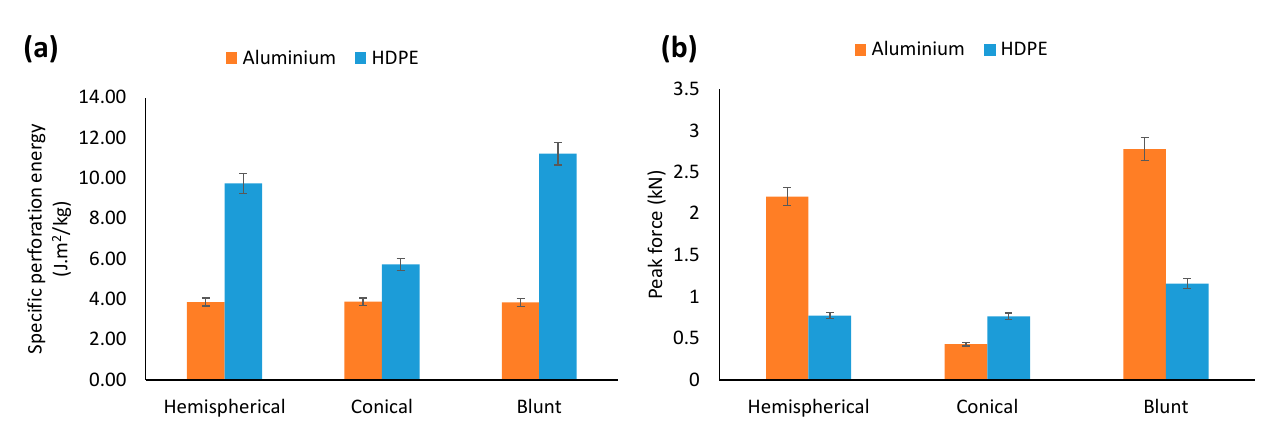
Figure 4. Comparison of the ( a ) specific perforation energy and ( b ) peak force to failure for monolithic aluminium and HDPE under hemispherical, conical and blunt indenters.